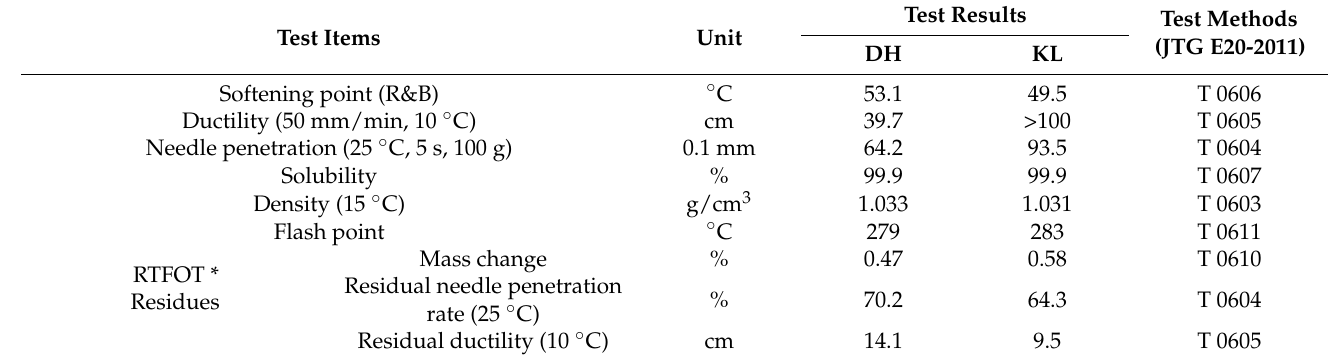
Table 1. Technical properties of asphalt.